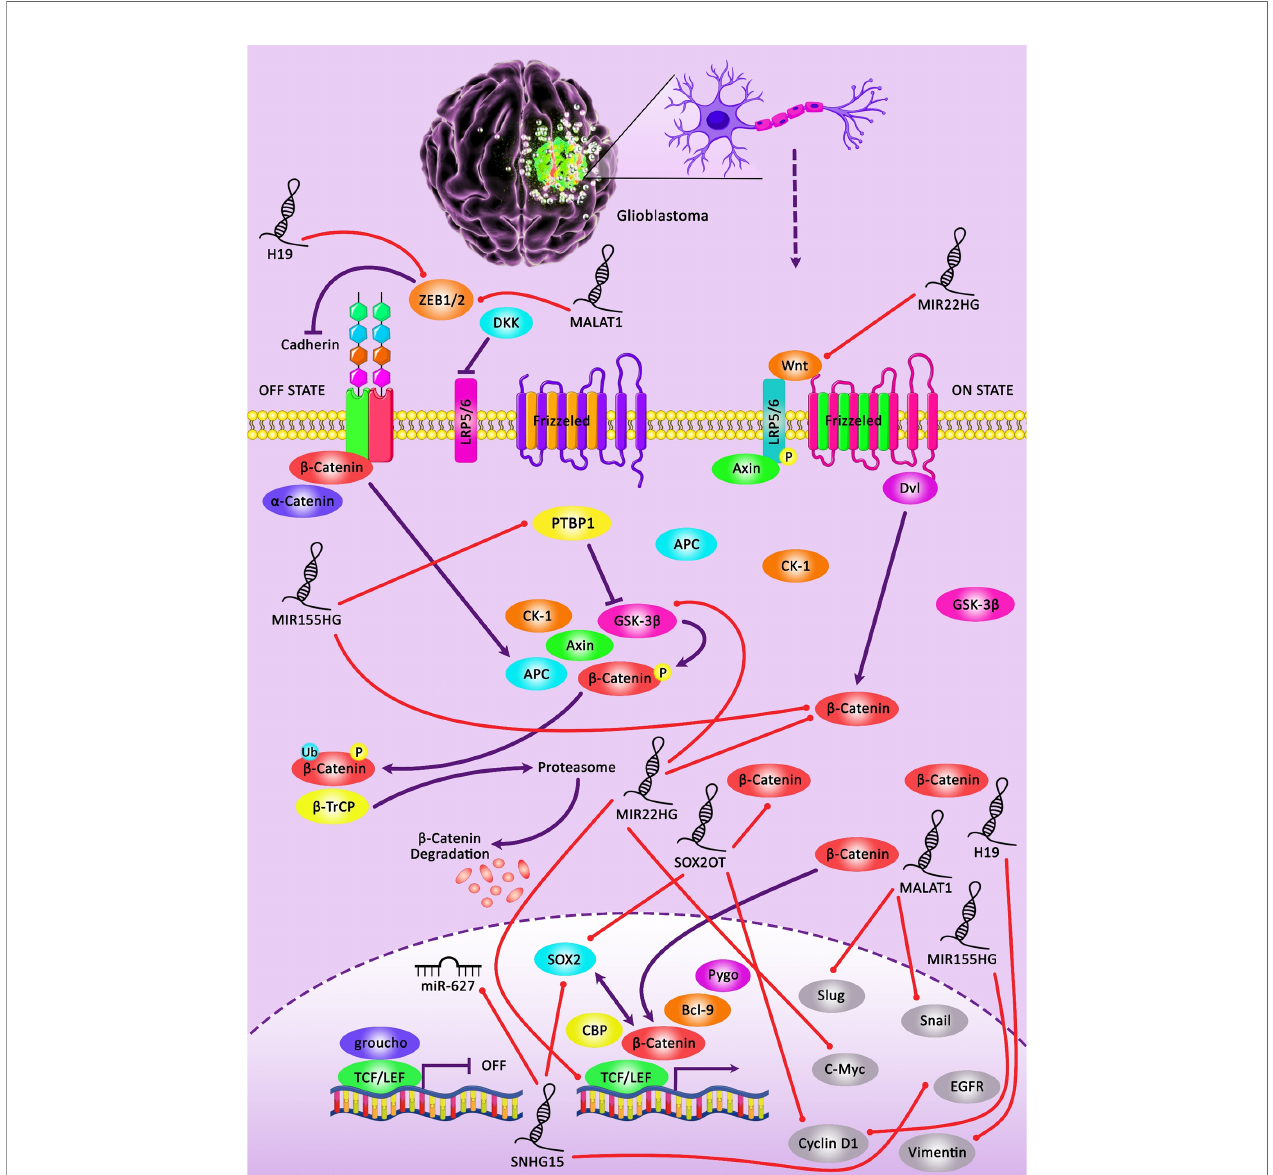
FIGURE 1 | A schematic illustration of the crosstalk between lncRNAs and Wnt/ b -catenin pathway involved in the modulation of the sensitivity of glioma cells to chemotherapeutic agents. Downregulation of lncRNA H19 could promote the sensitivity of glioma cells to temozolomide via inhibiting EMT through the suppression of the Wnt/ b -Catenin signaling cascade. Silencing of H19 could downregulate the expression level of b -catenin and its downstream targets c-myc and Survivin in temozolomide-treated glioma cells (11). Besides, downregulating the expression of lncRNA MIR22HG could suppress the Wnt/ b -catenin signaling pathway via loss of miR-22-3p and -5p. This could in turn lead to attenuating cell proliferation, invasion as well as tumor growth in glioma cells. MIR22HG silencing could result in downregulating the expression level of b -catenin, a key transcriptional regulator of Wnt, along with the inhibition of several Wnt downstream targets, containing c-Myc, cyclin D1, and LEF1, as well as a reduction in the expression of phospho-GSK3 b (Ser9) in tumor cells (12). Besides, upregulation of lncRNA MIR155HG could promote temozolomide resistance in glioma cells through directly regulating canonical Wnt/ b -catenin pathway activation via binding to PTBP1 in tumor cells